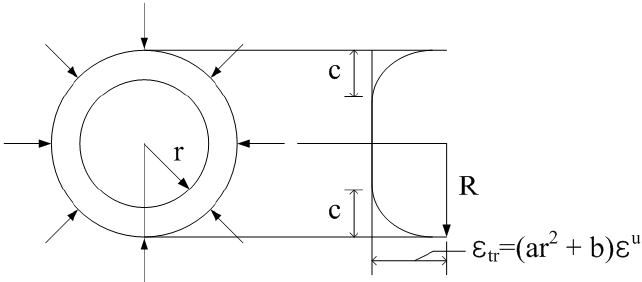
Figure 3. Strain distribution across cross-section of FRP rebar in tension [11].